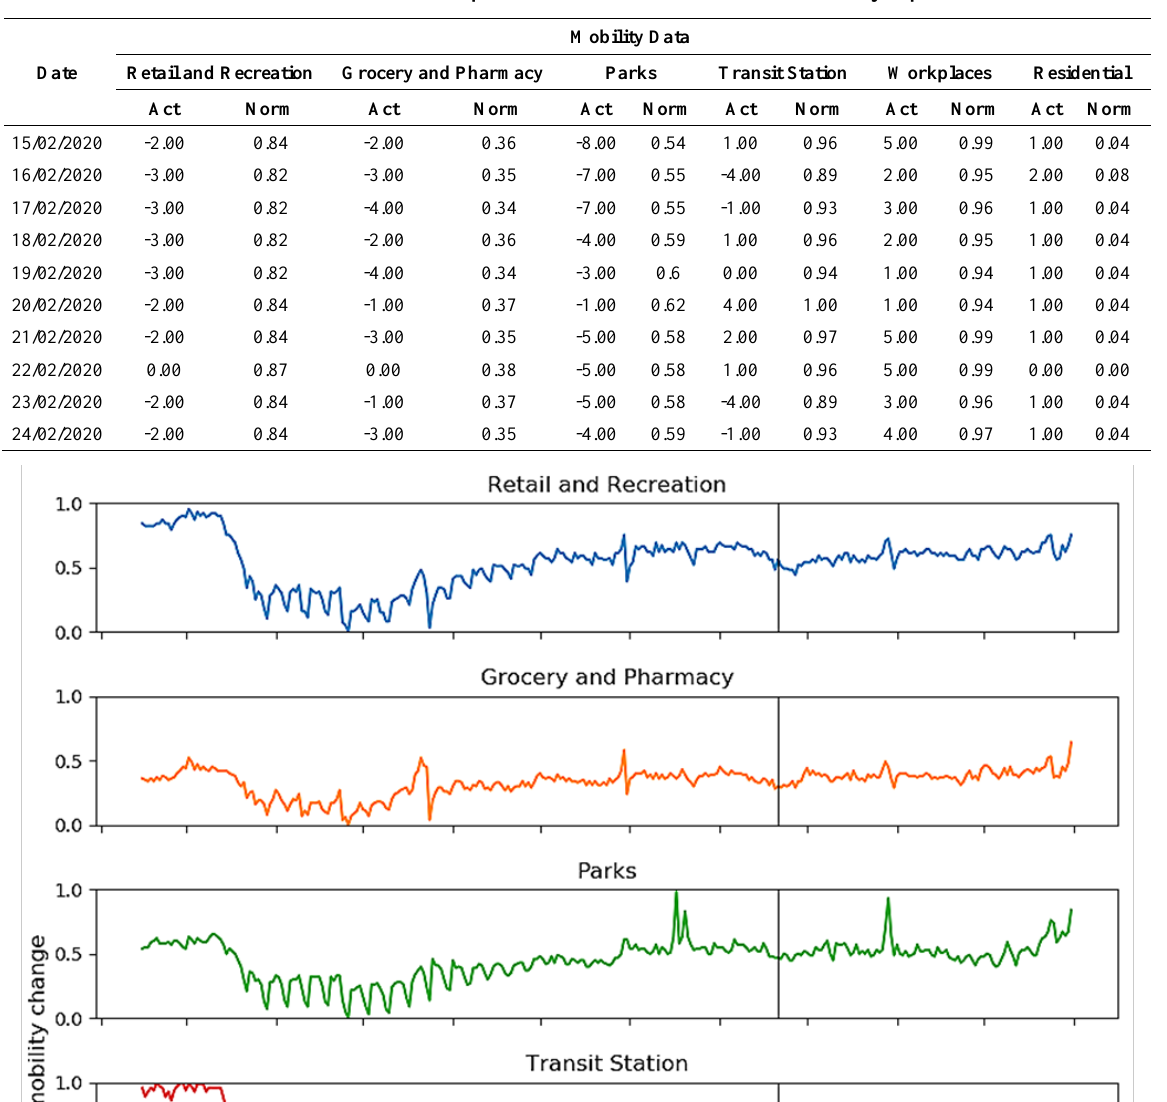
Table 1. Snapshots of daily mobility report data in the Indonesia region. The Act notation represent the actual mobility index while the Norm notation represent the normalized index calculated by Equation 3.